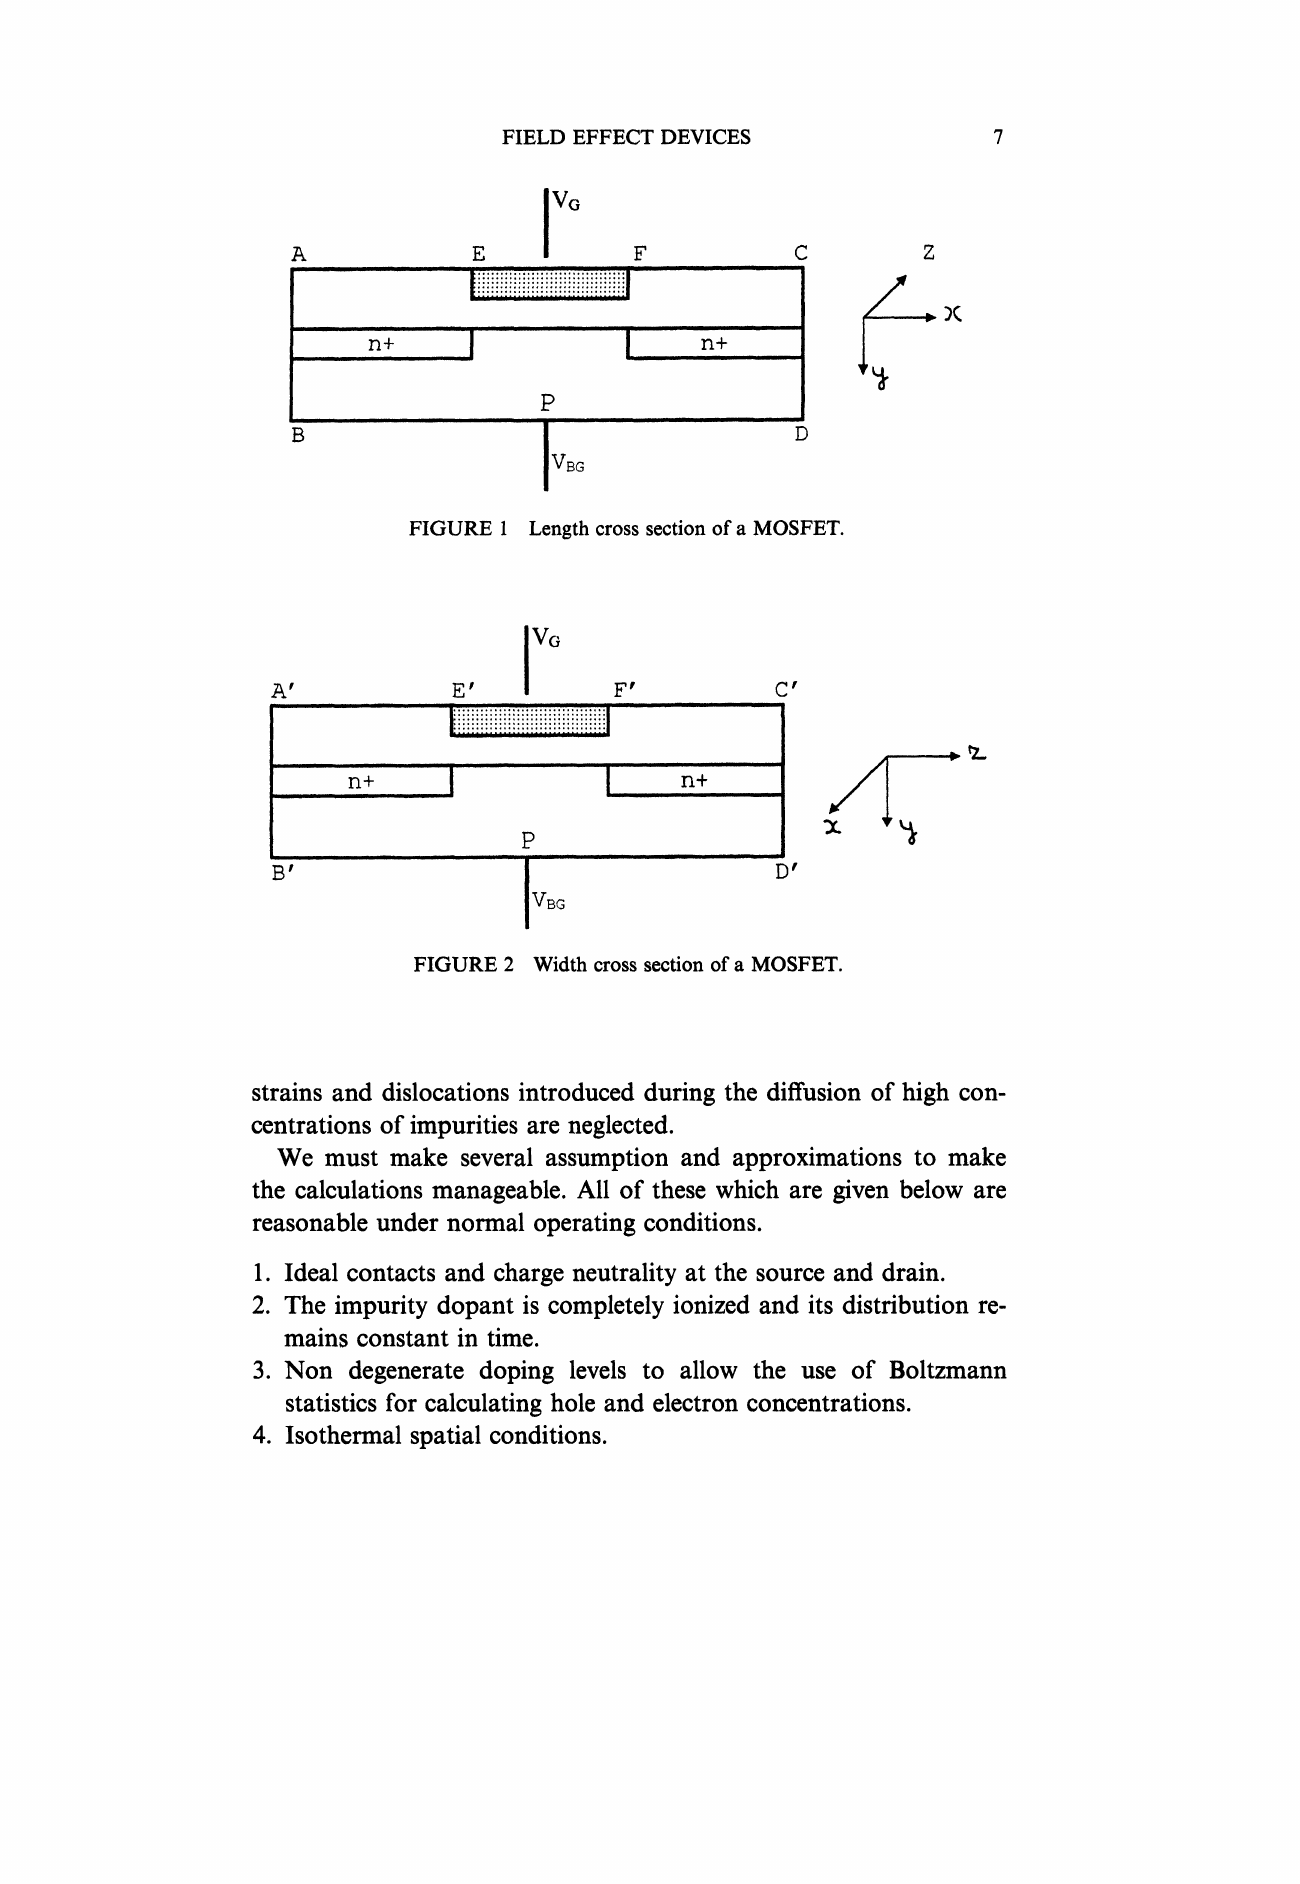
FIGURE Length cross section of a MOSFET.